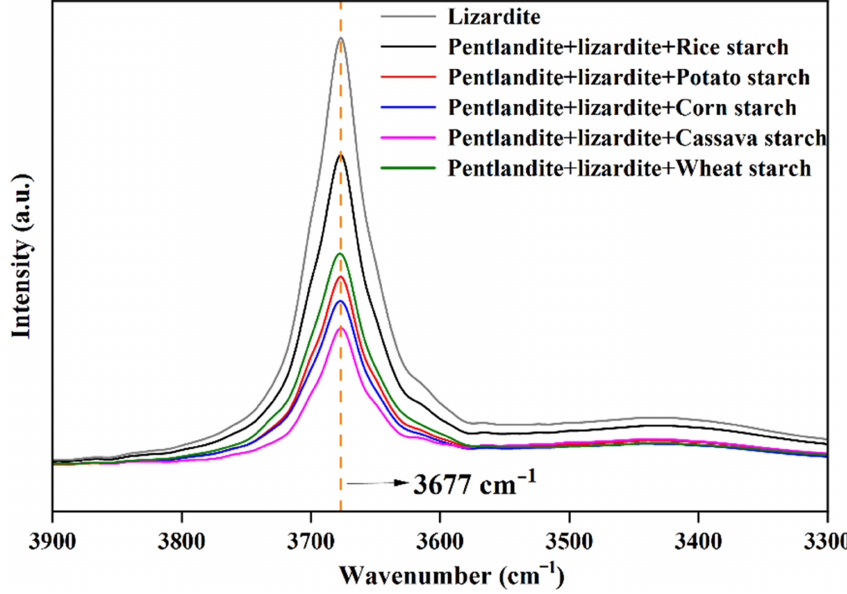
Figure 8. Infrared spectra of serpentine and flotation concentrate mineral samples of pentlandite mixed with serpentine in the absence and presence of 2 × 10 –2 g/L of depressants (pH = 9; [pentlandite] = 25 g/L; [serpentine] = 25 g/L). mixed with serpentine in the absence and presence of 2 × 10 − 2 g/L of depressants (pH = 9; [pent- landite] = 25 g/L; [serpentine] = 25